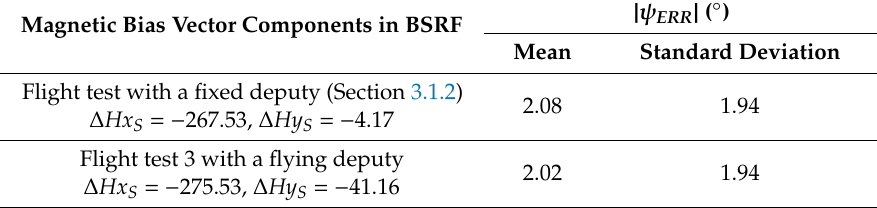
Table 4. Time statistics of the absolute value of the estimation error on the calibrated magnetic heading for the third flight test with a flying deputy. Comparison between two solutions for the magnetic bias vector